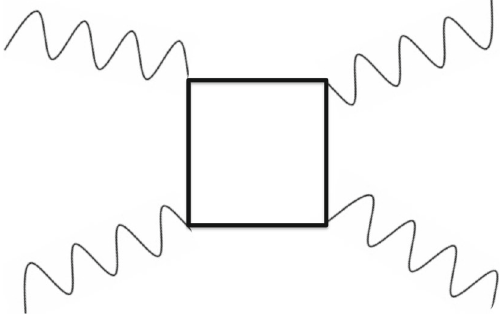
Fig. 1 Contribution to light-by-light scattering: γ γ → γ γ induced by a fermion loop